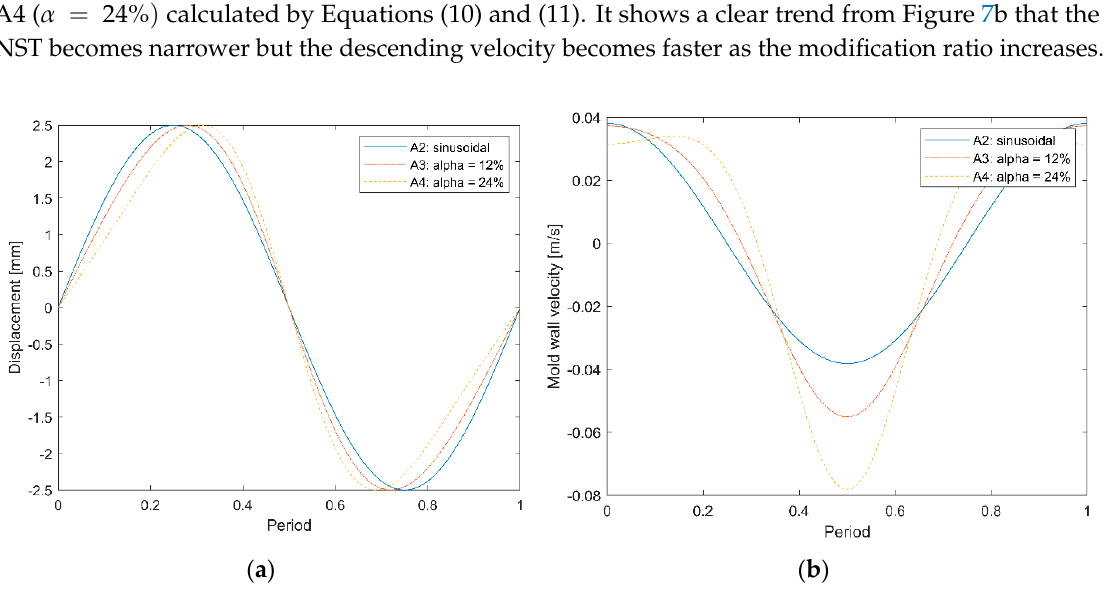
Figure 7. ( a ) Mold displacement and ( b ) velocity for Case A2, A3, and A4 during each oscillation